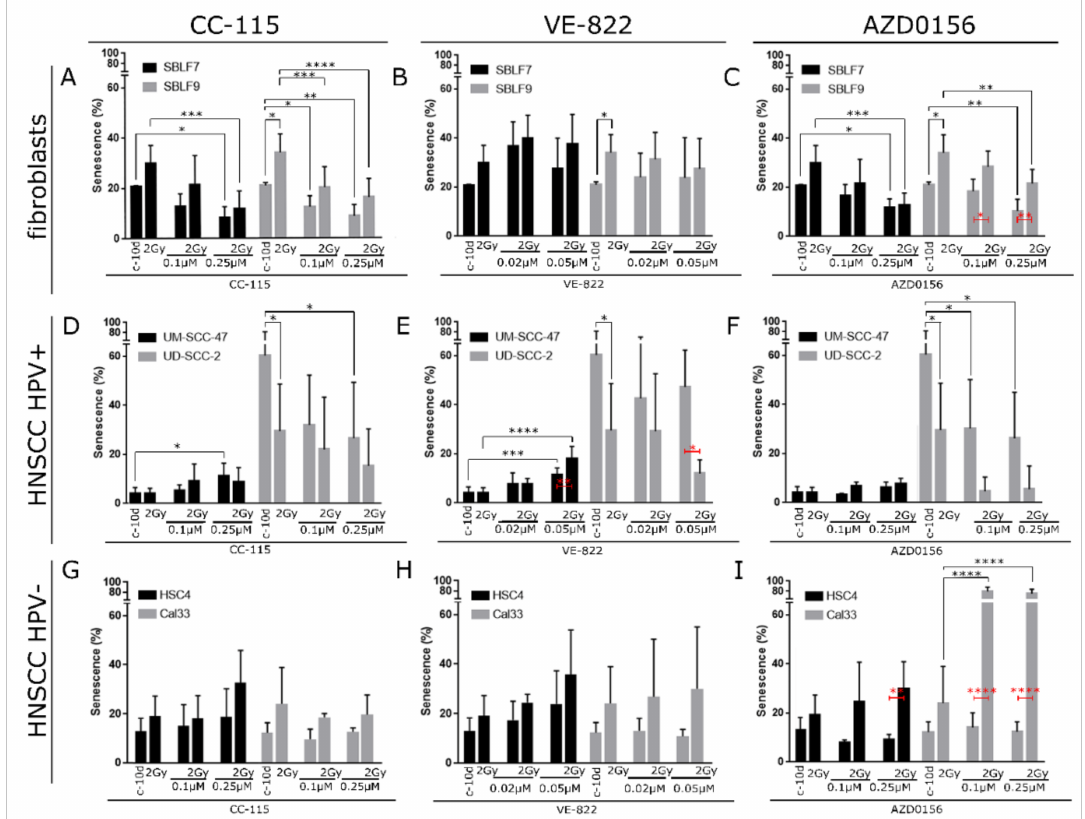
Figure 3. Senescence induction in two fibroblasts cell cultures, two HPV + and two HPV- HNSCC cell lines. Cells were treated by 2 Gy IR alone, DNA damage response inhibitors (DDRi) alone, or combined IR and DDRi, respectively. ( A ) Fibroblasts cell cultures SBLF7 and SBLF9 treated with DNA-PK and mTor inhibitor CC-115, ( B ) ATR inhibitor VE-822, and ( C ) ATM inhibitor AZD0156. UM-SCC-47 and UD-SCC-2 HPV + HNSCC cells treated with ( D ) DNA-PK and mTor inhibitor CC-115, ( E ) ATR inhibitor VE-822, and ( F ) ATM inhibitor AZD0156. HSC4 and Cal33 HPV-HNSCC cells treated with ( G ) DNA-PK and mTor inhibitor CC-115, ( H ) ATR inhibitor VE-822, and ( I ) ATM inhibitor AZD0156. Error bars indicate standard deviation. Each experiment was repeated three times at least. p -values shown for Holm–Sidak multiple comparisons test in black and red colors. * p < 0.05; ** p < 0.01; *** p < 0.001; **** p <